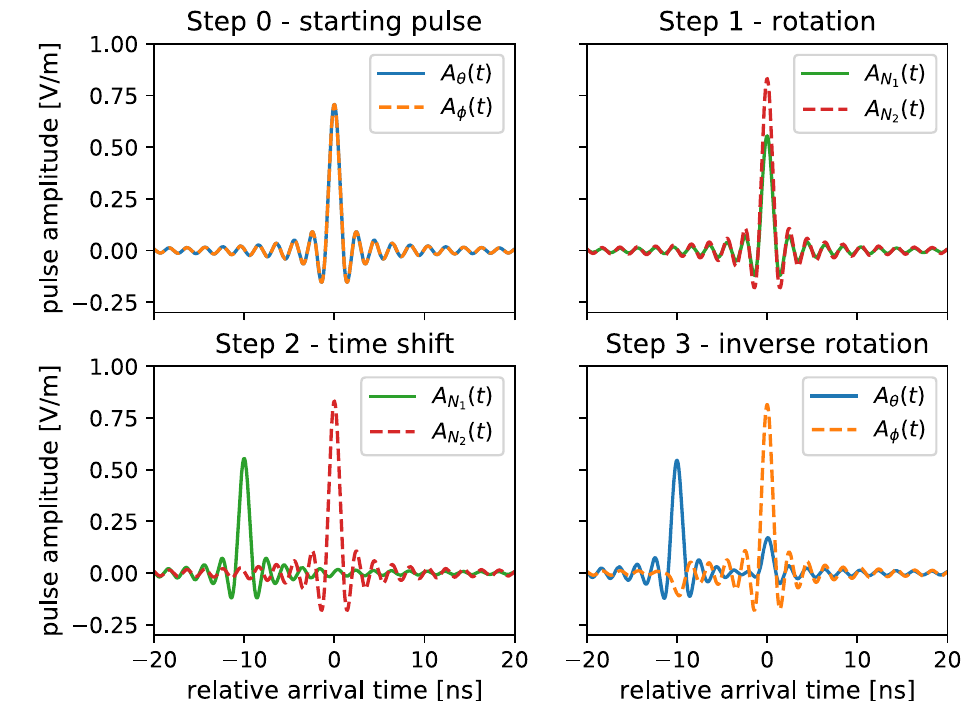
Fig. 3 Pulse propagation model for an artificial pulse shape with the created time traces at the source (step 0), the rotation into the time domain (step 1), the time shift applied to separate the pulses (step 2),